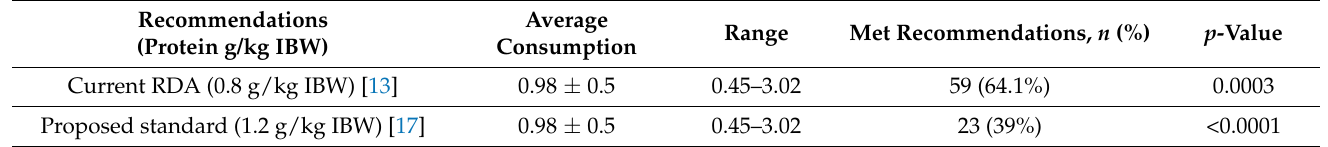
Table 4. Average protein consumption to weight comparison of current recommendations ( n =